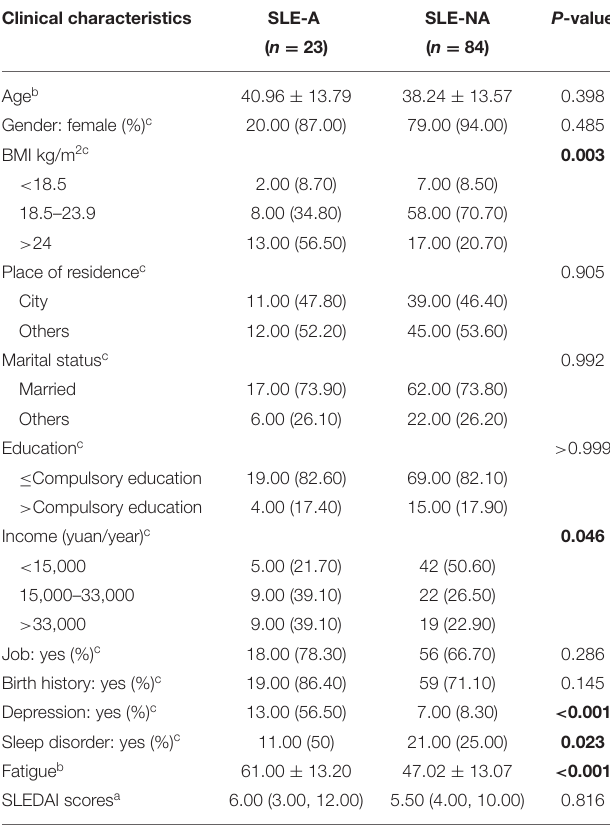
TABLE 1 | Clinical characteristics of SLE